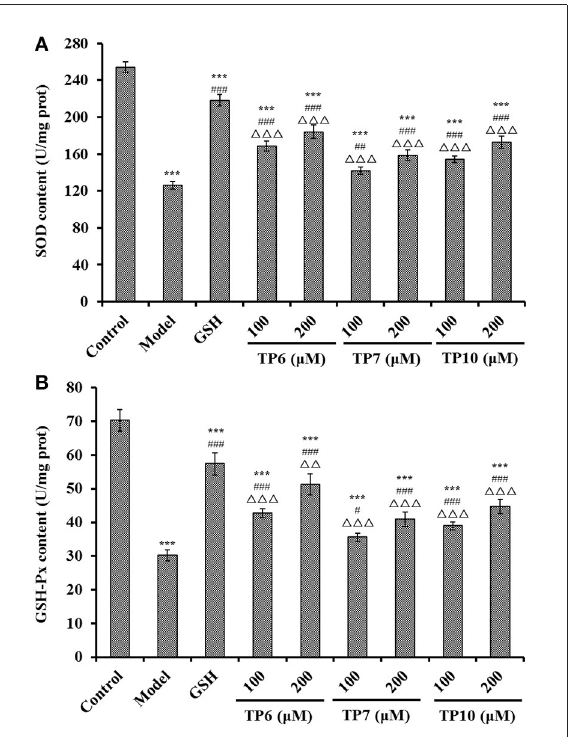
FIGURE11 Effects of TP6, TP7, and TP10 on the SOD (A) and GSH-Px (B) levels of H 2 O 2 -damaged HUVECs. All values are means ± SD ( n = 3). *** P < 0.001 and ** P < 0.01 vs. control; # P < 0.05, ## P < 0.01, and ### P < 0.001 vs. model; 11 P < 0.01 and 111 P < 0.001 vs.